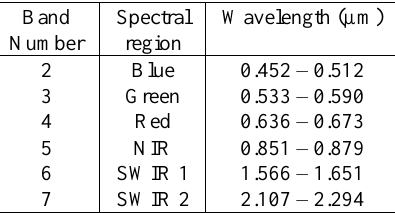
Table 1. Landsat image bands used for the image classification, and their respective wavelength